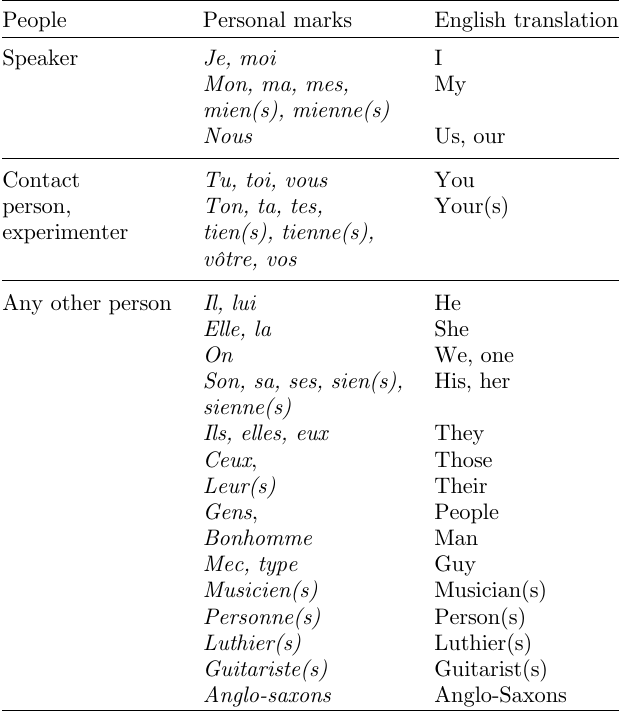
Table 5. Personal marks in the corpus in French by the kind of subjects, with a proposition of English translation.